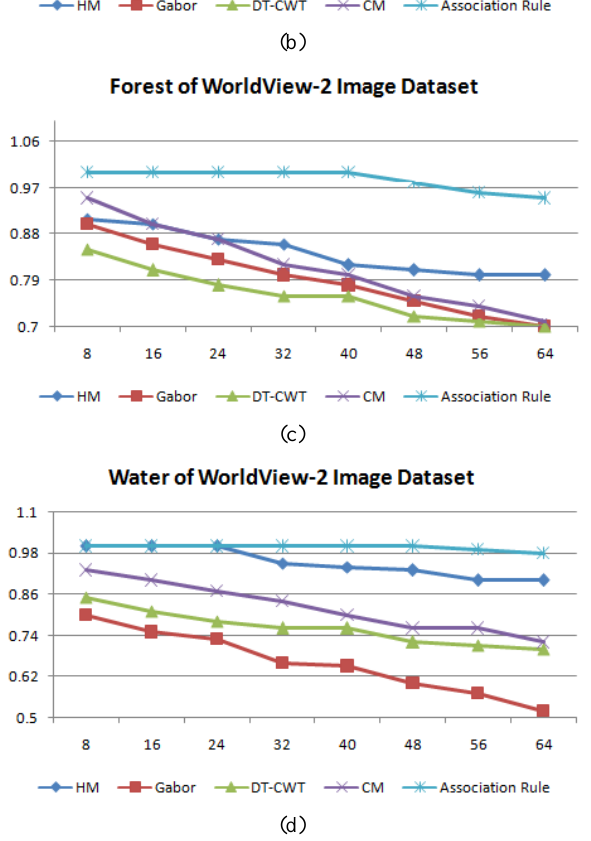
Figure 5. Objective evaluation results using average precision index. (a) and (b) are retrieval results of open forest and settlement from QuickBird image dataset, while (c) and (d) are the results from WorldView-2 image